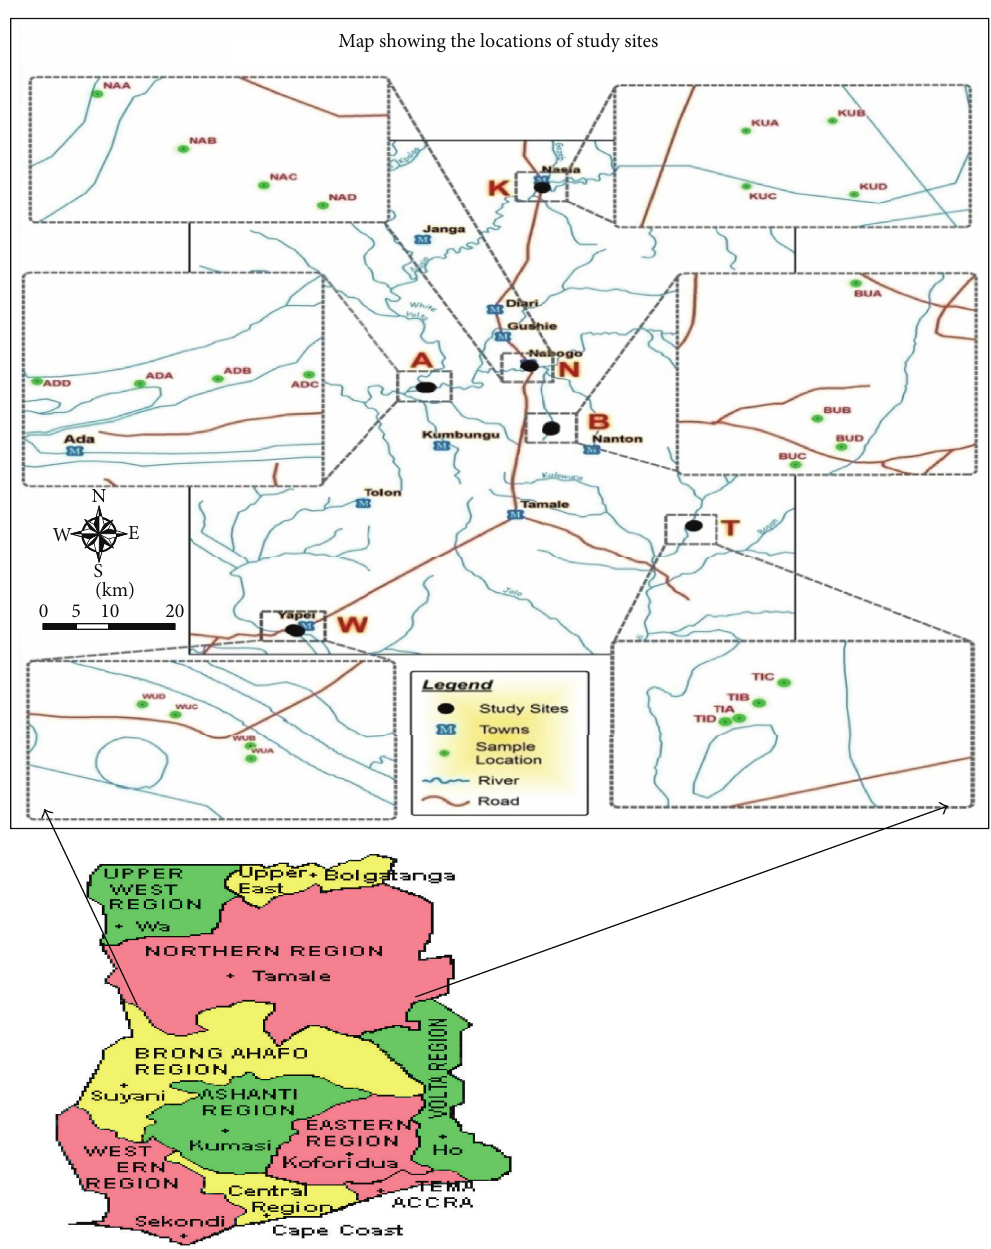
Figure 1: Map of the study areas, showing the location of the wetlands in the floodplains of the White Volta River catchment, Northern Region. The letters represent names of the wetlands; K = Kukobila, N = Nabogo, A = Adayili, B = Bunglung, T = Tugu, and W =